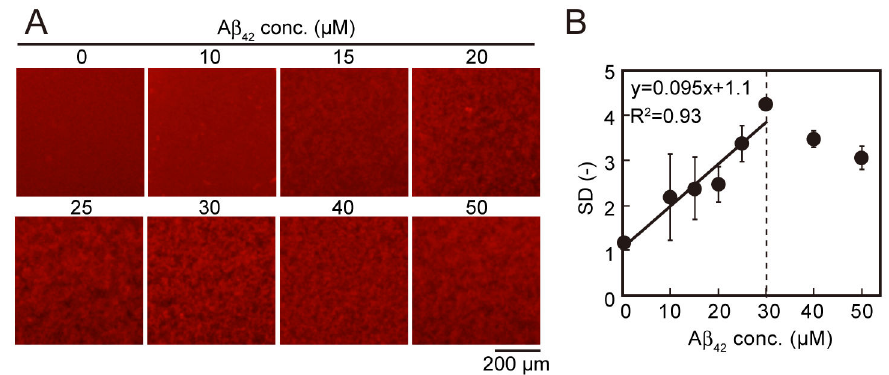
and 30 nM QDAβ were incubated in a 42 . A linear equation and R 2 in B were determined 42